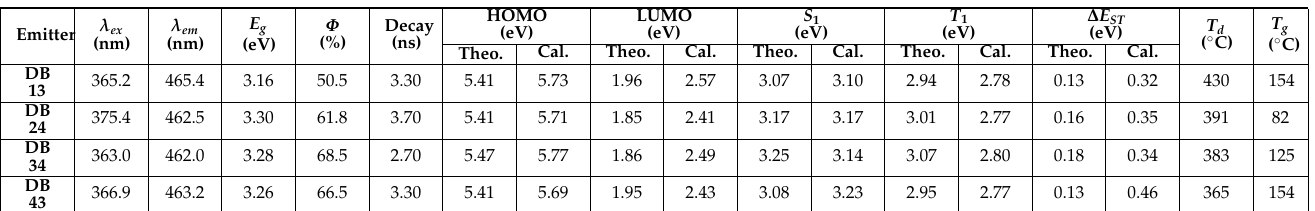
Figure 3. Electron density contours of frontier molecular orbitals (FMO) and HOMO, LUMO, singlet, triplet, and singlet–triplet energy gap electron distribution of the compounds DB13, DB24, DB34, and DB43. Table 1. The excitation wavelength ( λ ex ), emission wavelength ( λ em ), bandgap ( E g ), PLQY ( Φ ), decay time, theoretical and calculated HOMO-LUMO levels, values of singlet energy ( S 1 ) and triplet energy ( T 1 ), singlet–triplet energy gap ( ∆ E ST ), decomposition temperatures ( T d ) and glass-transition temperatures ( T g ) of the compounds DB13, DB24, DB34 and